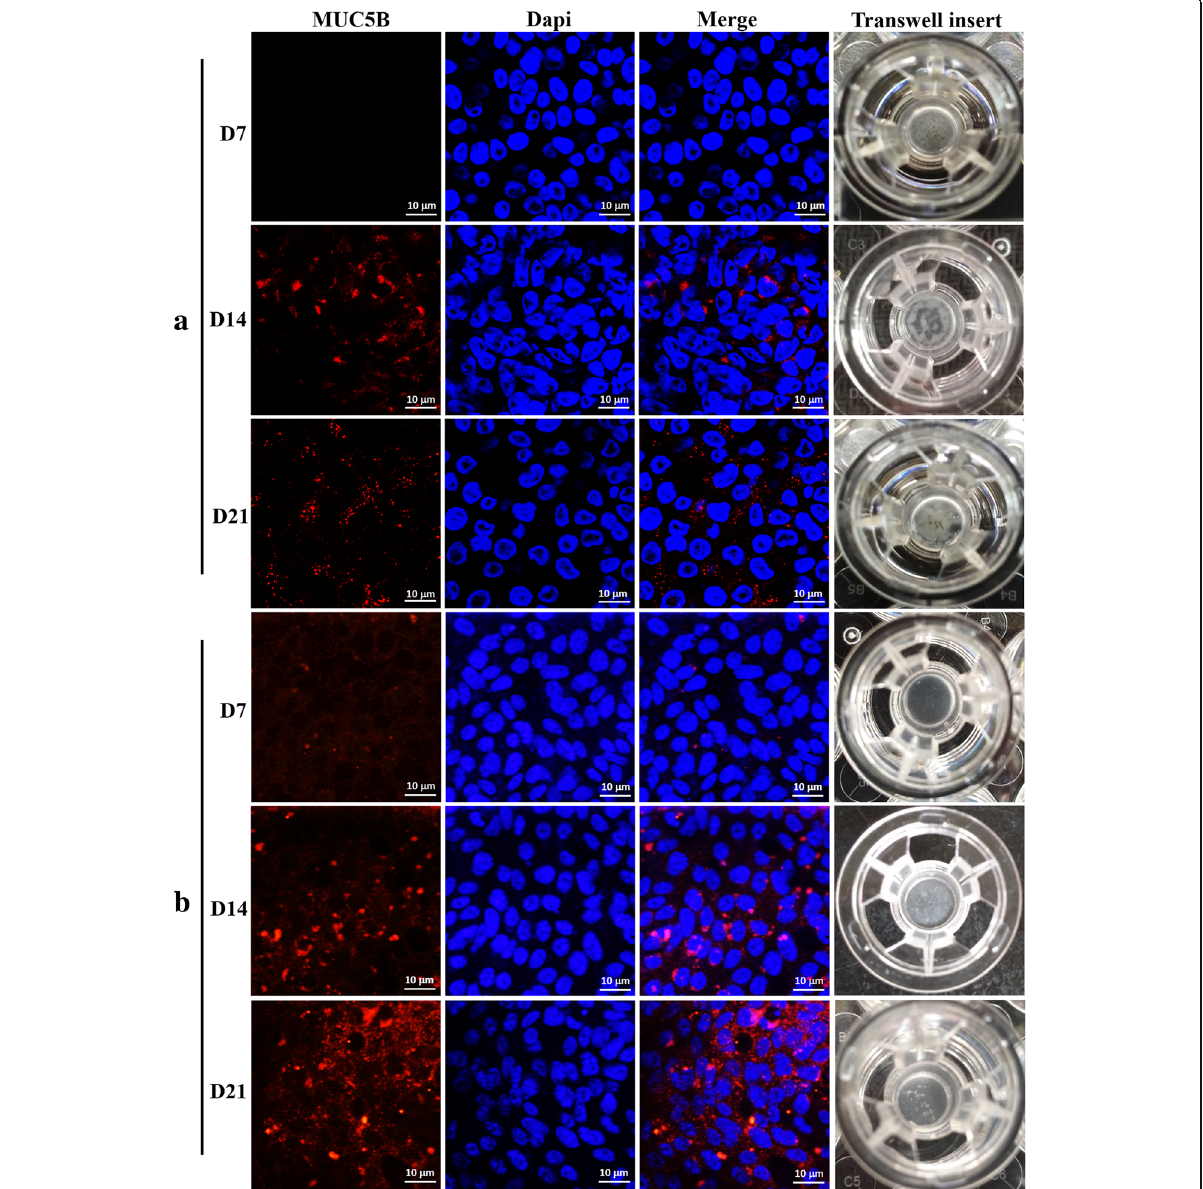
Fig. 5 Mucus secretion by immortalized STEC line and primary STECs cultured under Ali conditions. Immortalized STEC line and primary STECs were cultured under Ali conditions for 21 days. At D7, D14, and D21, the cells were fixed with 4% paraformaldehyde and stained with an anti-MUC5B antibody, followed by incubation with a Alexa Fluor 555-conjugated goat anti-rabbit secondary antibody. The cells were then counterstained with DAPI and imaged using laser scanning confocal microscopy ( a , b